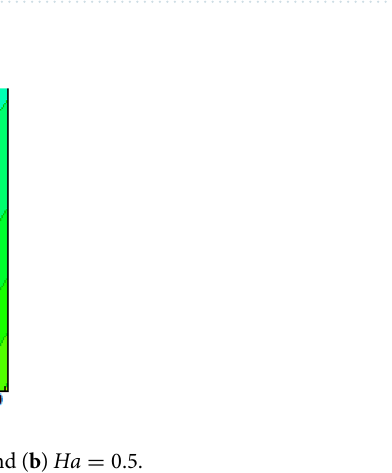
Figure 23. Streamlines for flow parameters when We N